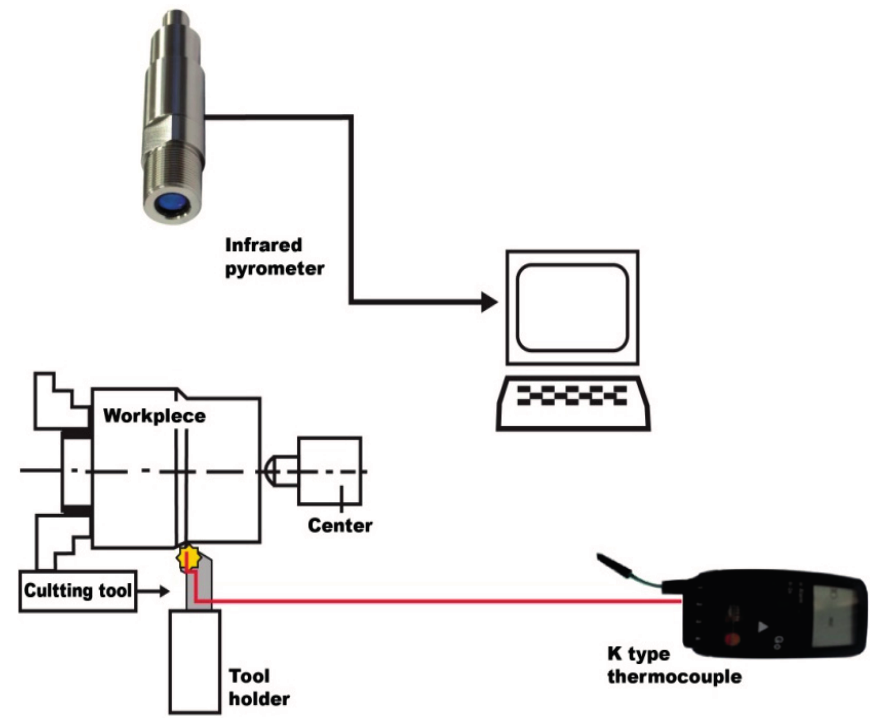
Figure 3. Schematic view of the experimental